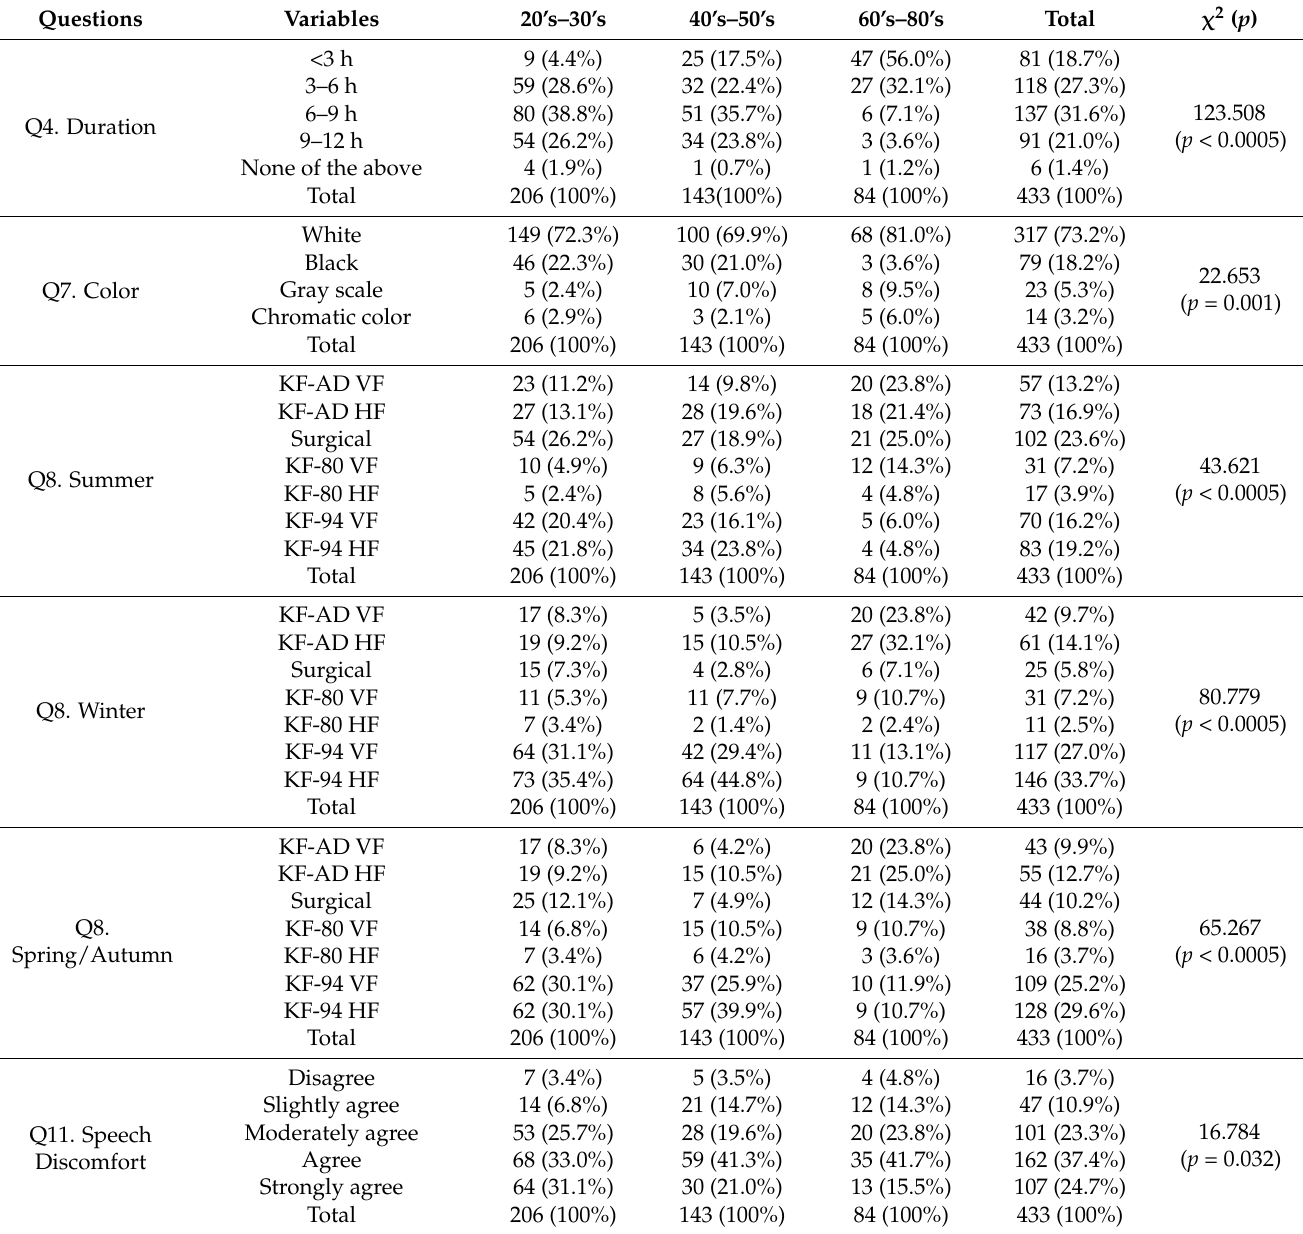
Table 6. Chi-squared test results according to age.